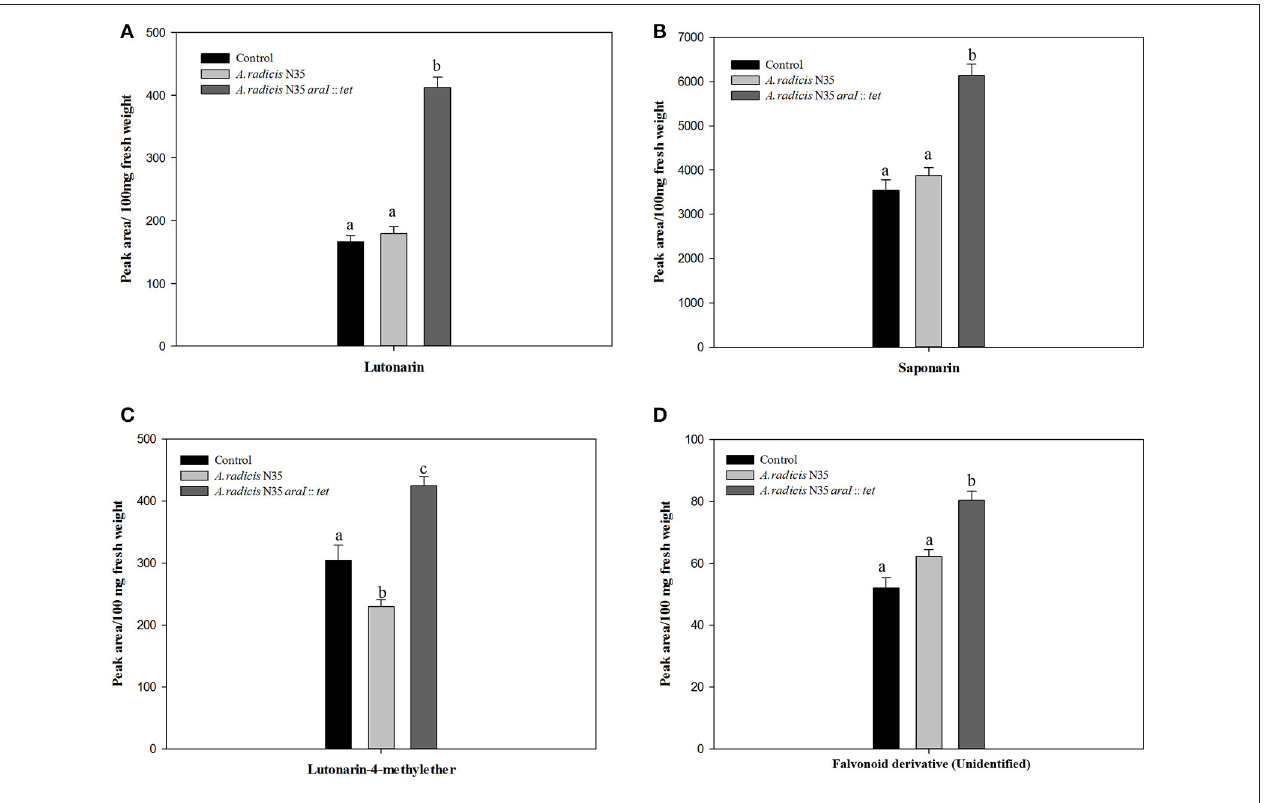
FIGURE 6 | Accumulation of flavonoids in barley leaves measured by HPLC. The flavonoid components are (A) lutonarin, (B) saponarin, (C) lutonarin-4-methylester, (D) an unidentified flavonoid derivative. Different letters indicate significant differences among treatment groups ( p < 0.05).